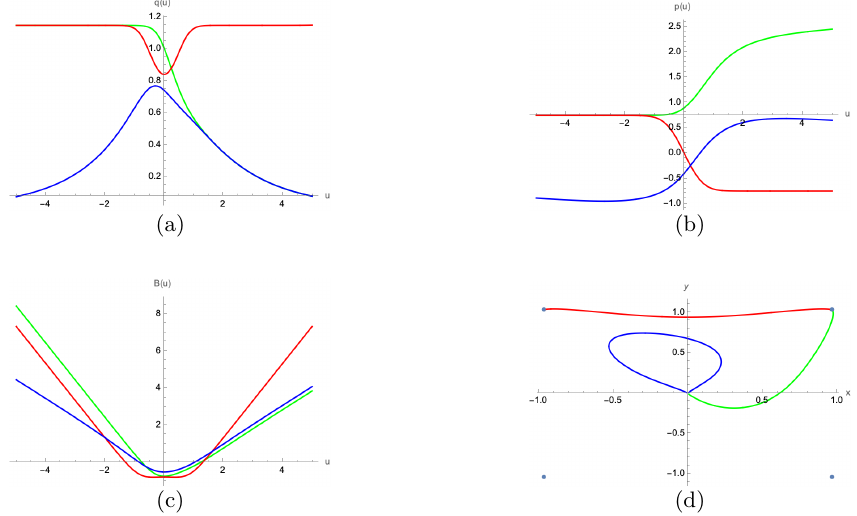
Figure 4. Truncation 2: (a)-(c) plots of p, q, B respectively, (d) parametric plot of the Janus flow in the x, y variables, the N = (4 , 4) vacuum is at the origin and the dots denote the locations of the N = (1 , 1) vacua. Blue: Janus between N = (4 , 4) vacua, red: Janus between N = (1 , 1) vacua, green: RG-Janus between N = (4 , 4) and N = (1 , 1) . We have set α = 1 . 2 for these